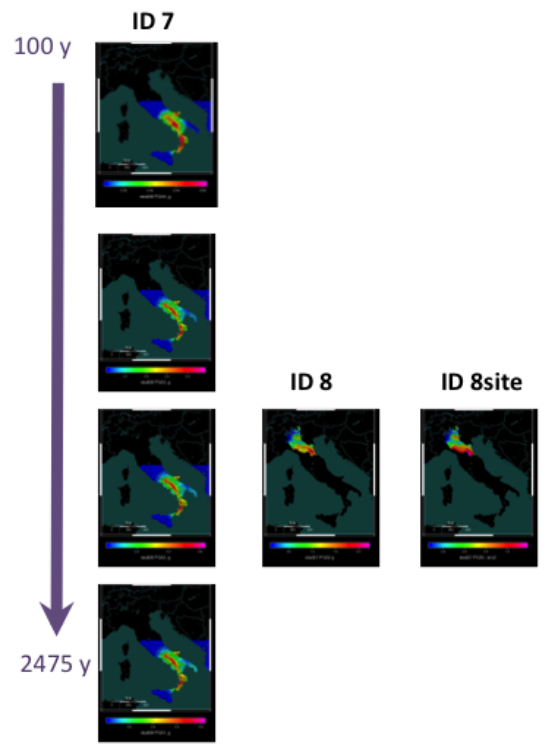
Figure 8. Synoptic view of regional PSHA maps collected by S2- 2012 project. Model IDs refer to Table 1; the vertical axis shows approximately the return period the elaborations refer to. The colour scale is automatically adjusted on values; full size maps and other graphic details are given in Supplement B.